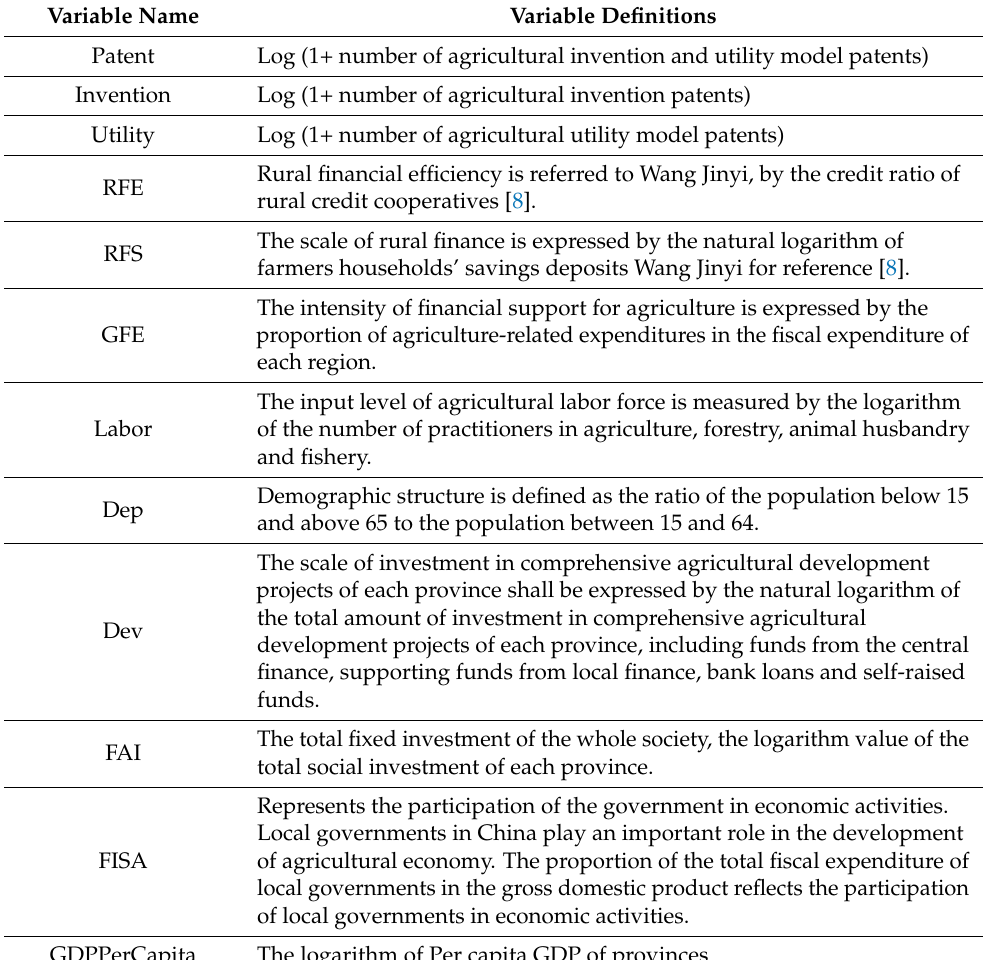
Table 1. Variables